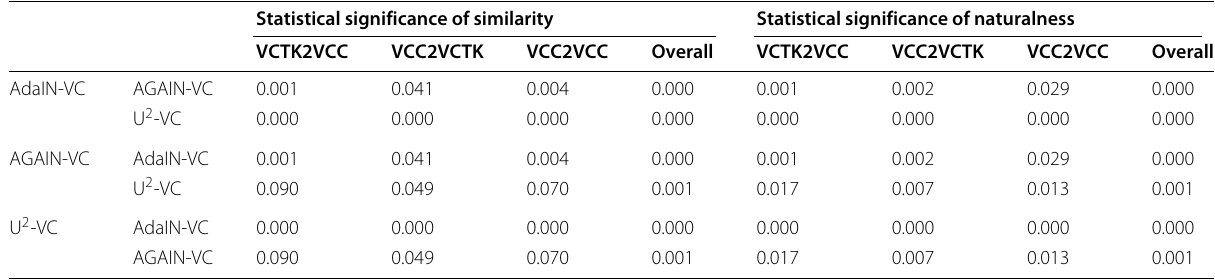
Table 14 Statistical significance of the MOS results in cross-lingual conversion scenario. “Overall” represents the overall statistical analysis of all the three conversion